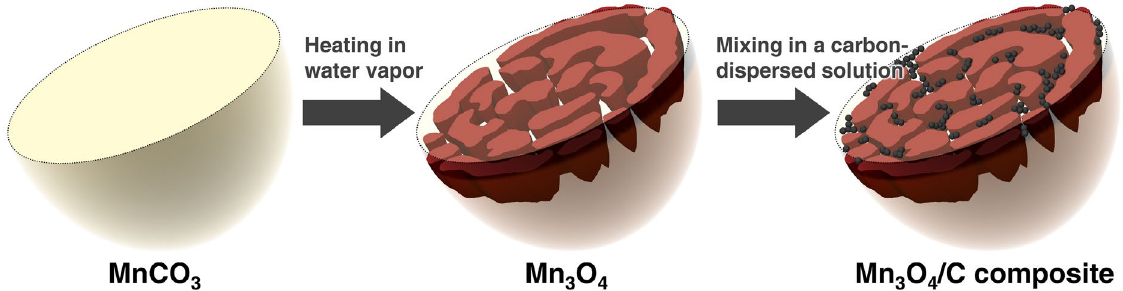
Figure 1. Schematic illustration of the fabrication process of Mn 3 O 4 /C